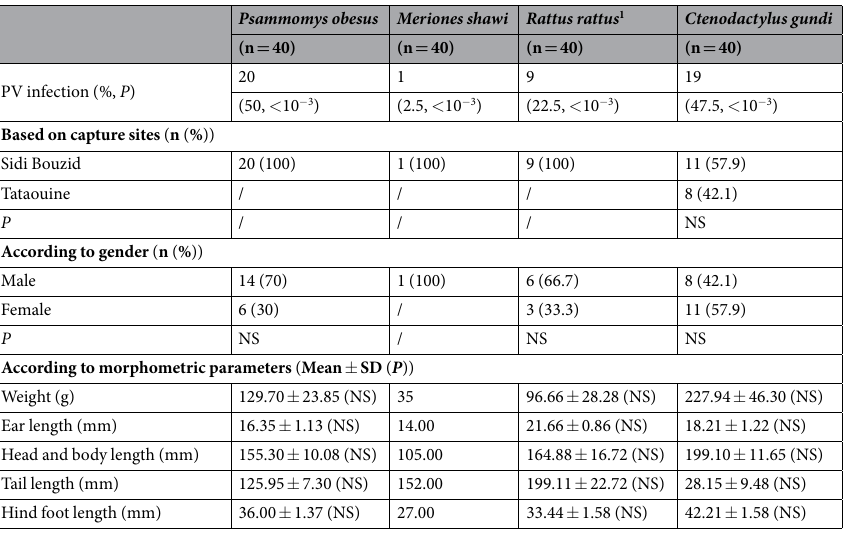
Table 1. Detection by RT-PCR of PV infection in rodents from Tunisia based on sampling site and different biological parameters. NS: Not significant. 1 Introduced.